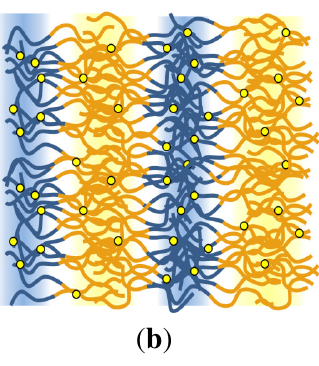
Figure 4. Nanostructures formed by a polymer blend of A and B homopolymers and reversibly crosslinked AB block copolymers. Shown are sketches of ( and ( b ) the lamellar phase. Blue and yellow lines represent copolymers, yellow circles denote crosslinkers. A and B homopolymer densities are indicated by the light blue and yellow background colors. Results of